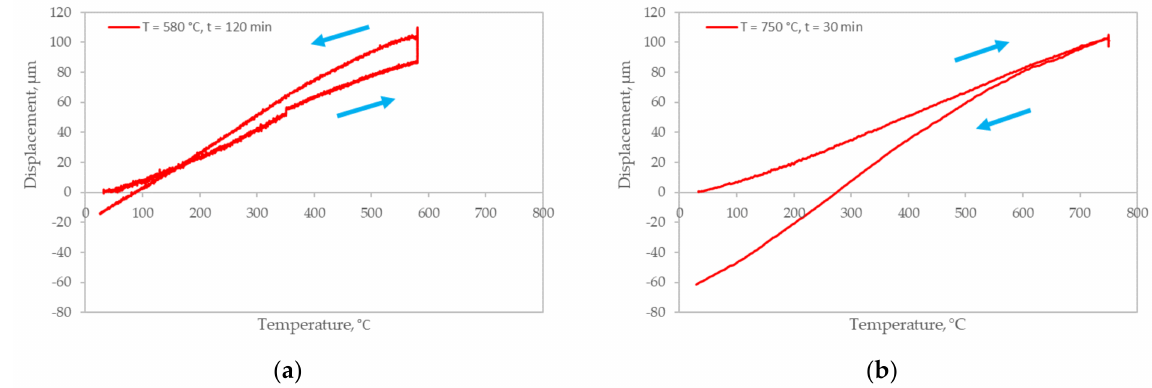
Figure 7. Dilatometric curves of spark plasma sintered zirconium at 800 ◦ C with subsequent heat treatment at temperature and holding time: ( a ) 580 ◦ C and 120 min; ( b ) 750 ◦ C and 30